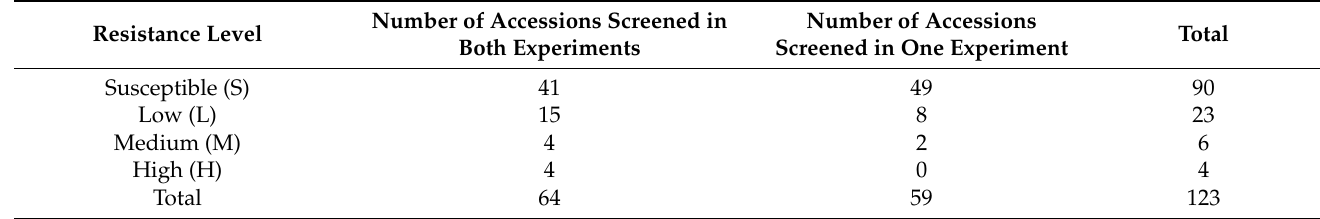
Table 3. Summary of disease ratings and resistance classifications of Cucumis accessions. Resistance